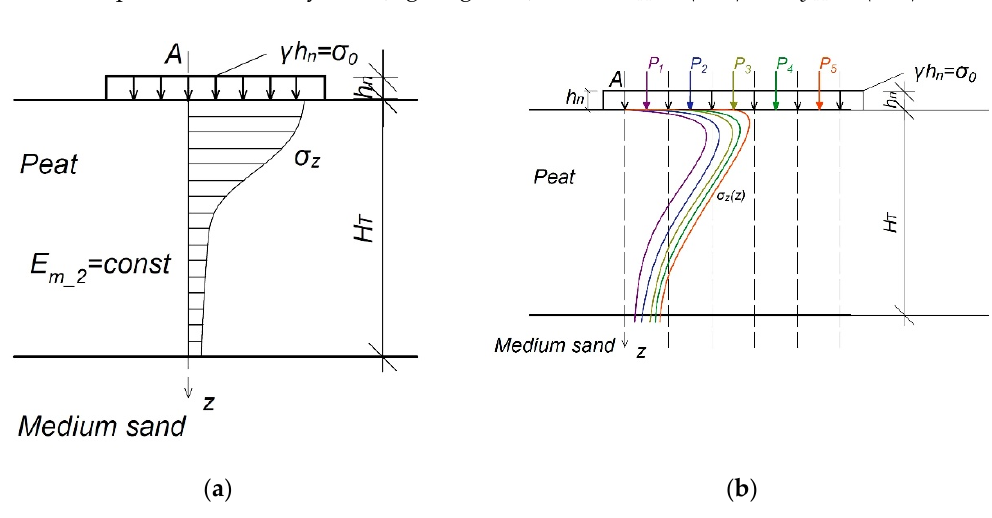
Figure 8. The scheme adopted in the second model: ( a ) calculating a column of soil organic; ( b ) influence of the load from the remaining calculation areas on the stress distribution in the analyzed point; P 1–5 , forces acting in the centre of the calculation area (kN); A , analysed point ( − ); h n , the height of the embankment (m); γ , the weight of the embankment (kN m − 3 ); z , axis of depth.